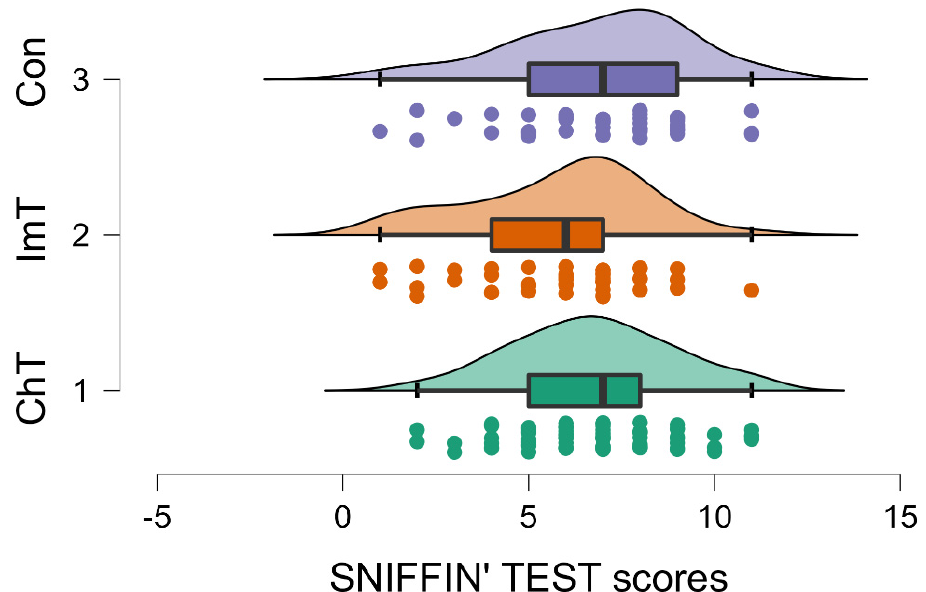
8 of 14 Table 4. Descriptive statistics for MMSE, Sniffin’ Test, G8 and Diet scores for Group 1 (i.e., chemotherapy), Group 2 (i.e., immunotherapy) and Group 3 (i.e., geriatric control group). MMSE